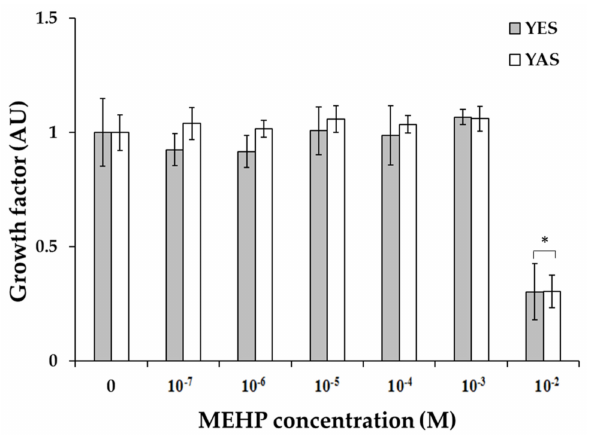
Figure 1. The growth factors of YES and YAS Saccharomyces cerevisiae yeasts after MEHP exposure. Asterisk means the growth factor of samples is below 0.5.